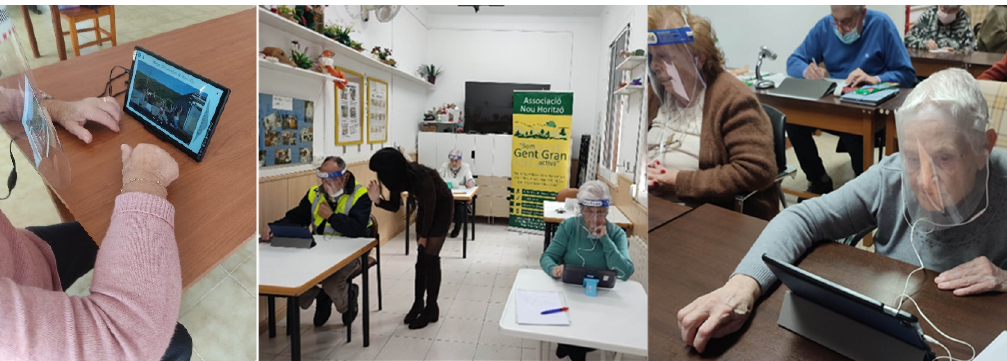
Figure 3. Volunteers during a LONG-REMI session.